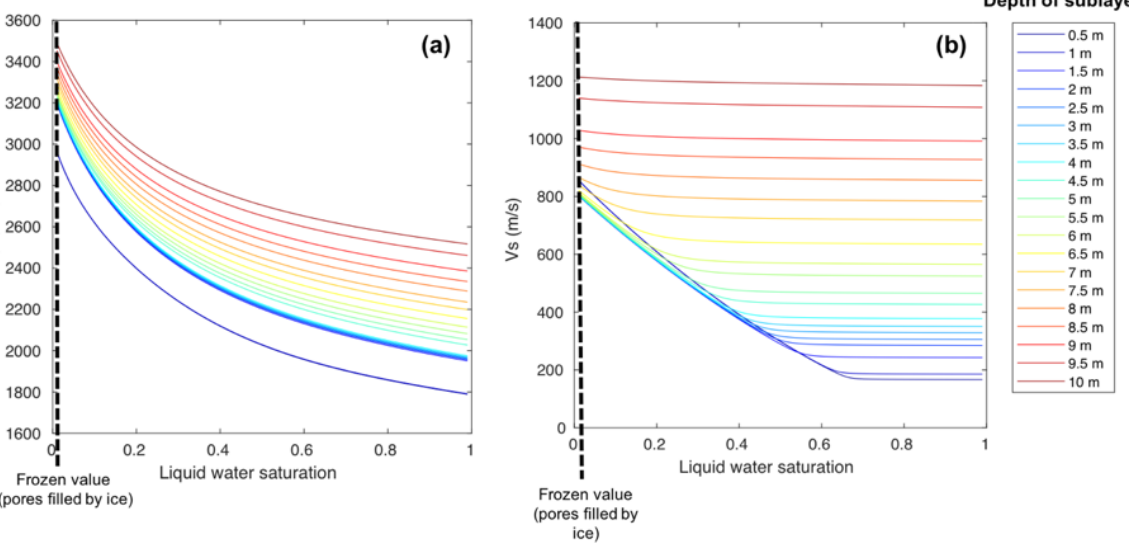
Figure 8. (a) Evolution of P-wave velocity V p with respect to the ratio between water and ice filling the pores, resulting from the Biot– Gassmann-type three-phase poroelastic model, applied to the Laurichard rock glacier (for C00 seismometer). The different curves correspond to the different sublayers, whose depth is indicated in the right panel. The V p values used to model the winter state are those for liquid water saturation tending towards zero. (b) Same results for S-wave velocity V s